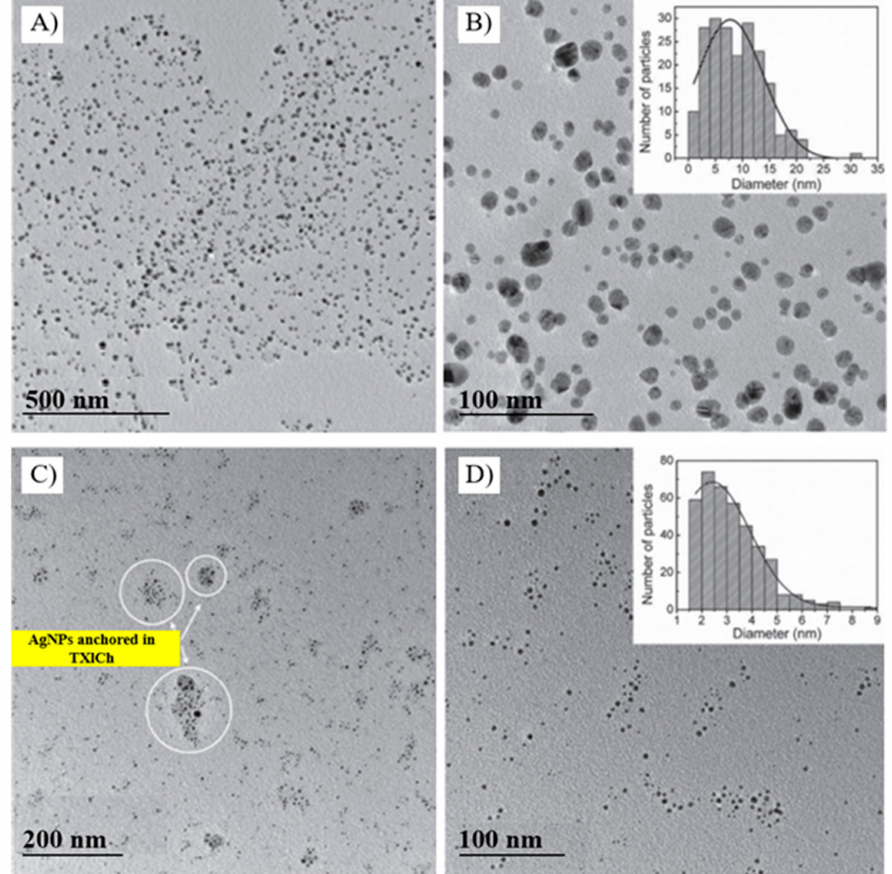
Figure 4. TEM images of spherical Ag NPs/TXICh (as the photoinitiator and stabilizer) in the absence of TEOH ( A , B ) and in its presence ( C , D ). The reaction mixtures were irradiated using a 365 nm UV light with a power of 92 mW cm − 2 . Adapted from [94]. Published by The Brazilian Chemical Society under Open Access